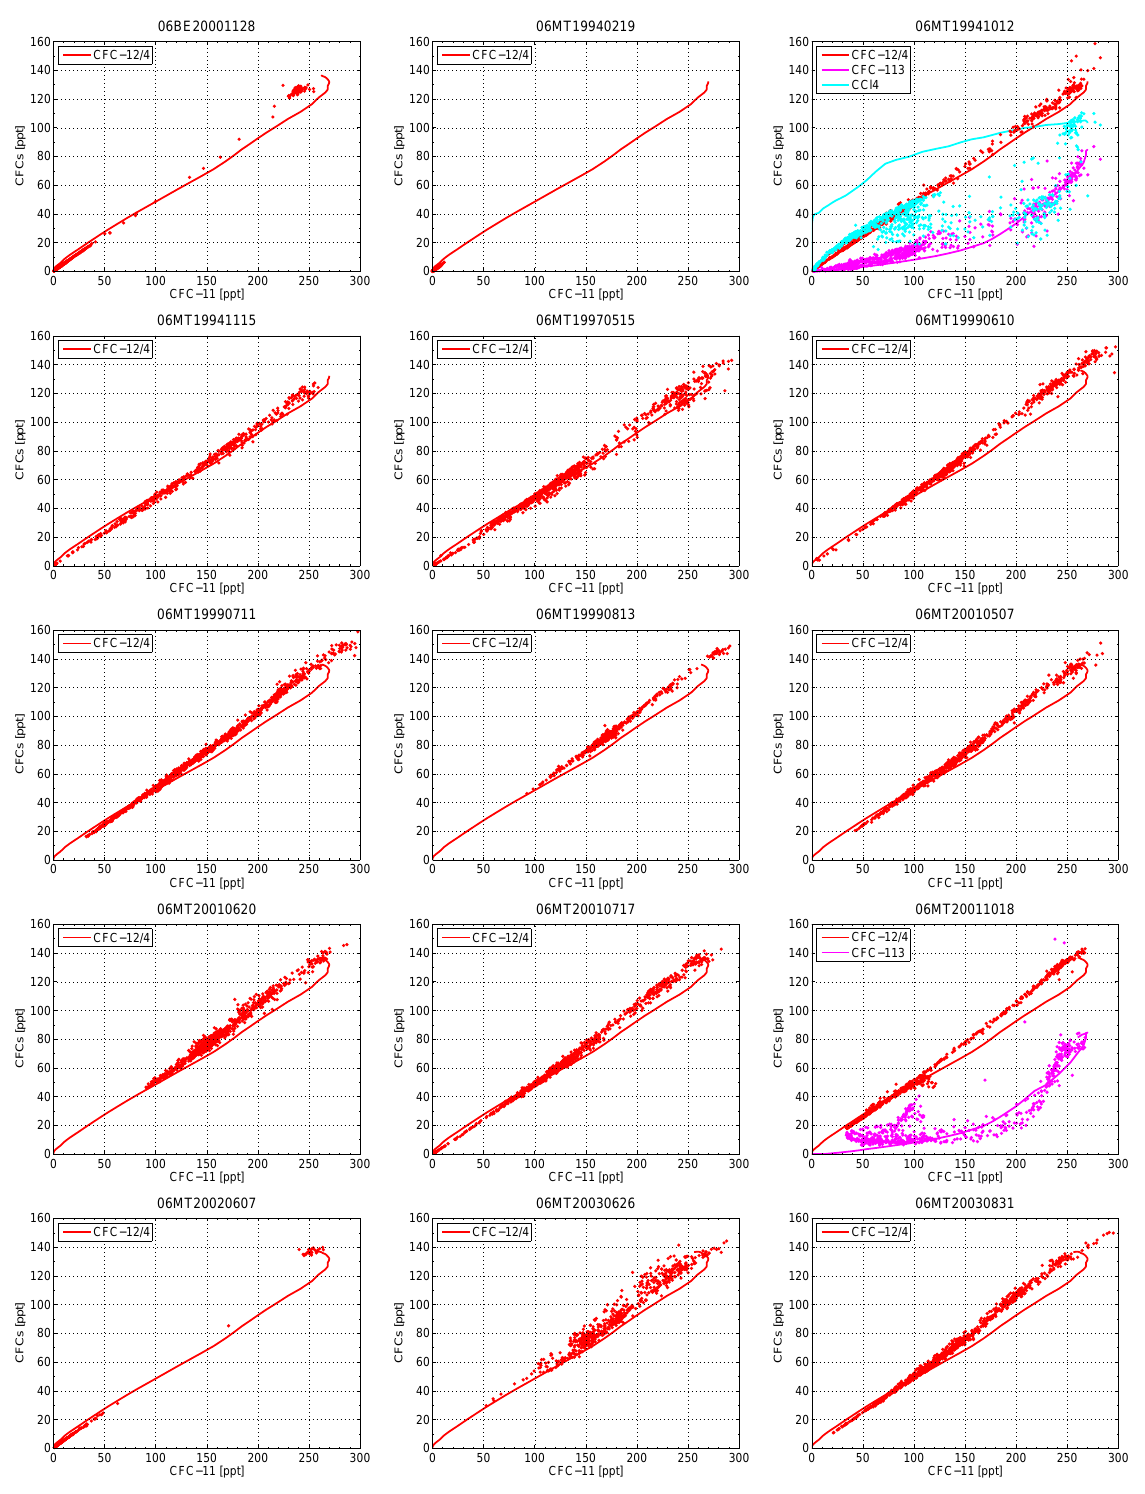
Figure 8. Property-property plot for CFC-12, CFC-113, and CCl 4 against CFC-11 from the CARINA Atlantic data set. Oceanic CFC concentrations are converted to atmosphric mixing ratios, and the ratio of the atmospheric CFC concentrations are indicated by the solid lines. CFC-12 mixing ratios are devided by 4 to fit the